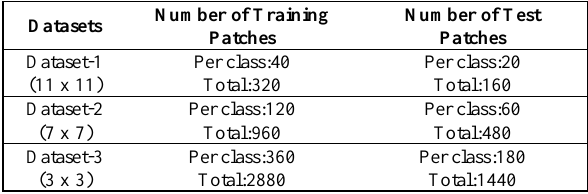
Table 1: Distribution of train test patches for each Dataset To compare the accuracy of thematic maps using different classification techniques, WV-2 image was also classified by applying pixel-based technique using XGBoost and CatBoost algorithms. To perform pixel-based classification process, 3,240 pixels for each class (i.e., total of 25,920 pixels) were chosen as training samples and test dataset consisted of totally 12,960 pixels (i.e., 1,680 pixels for each LULC classes). To